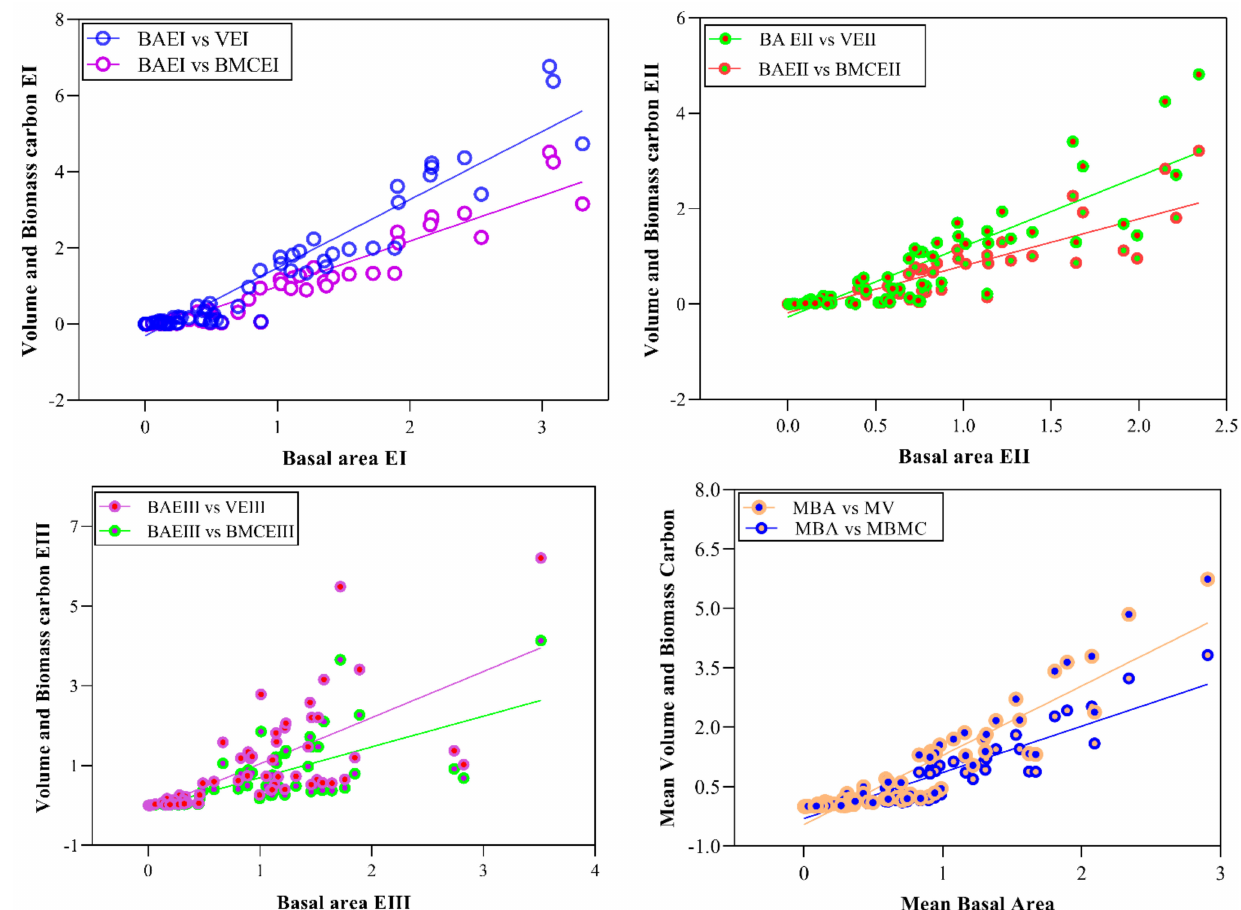
Figure 3. Relationships between Basal area with volume and biomass carbon along different al- titudinal gradients. Note. BAEI = Basal area at elevation zone-I, BAEII = Basal area at elevation zone-II, BAEI = Basal area at elevation zone-III, MBA = Mean basal area, VEI = Volume at elevation zone-I, VEII = Volume at elevation zone-II, VEIII = Volume at elevation zone-III, MV = Mean vol- ume, BMCEI = Biomass carbon at elevation zone-I, BMCEII = Biomass carbon at elevation zone-II, BMCEIII = Biomass carbon at elevation zone-III, MBMC = Mean biomass